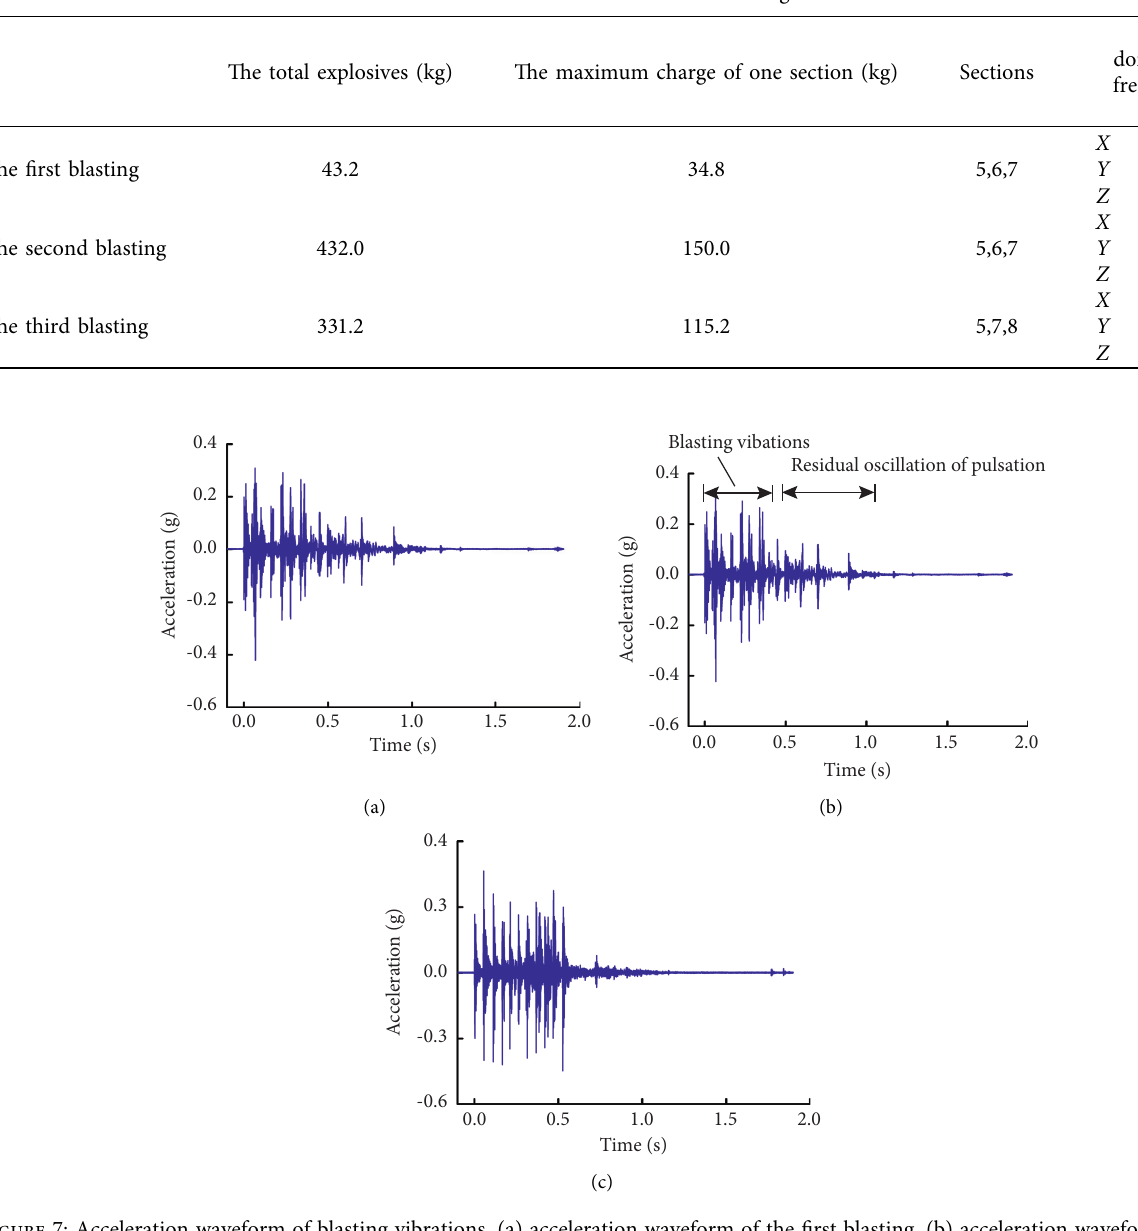
Figure 6: Schematic diagram of explosion source and measuring points m . Table 3: Results of three tests of blasting.